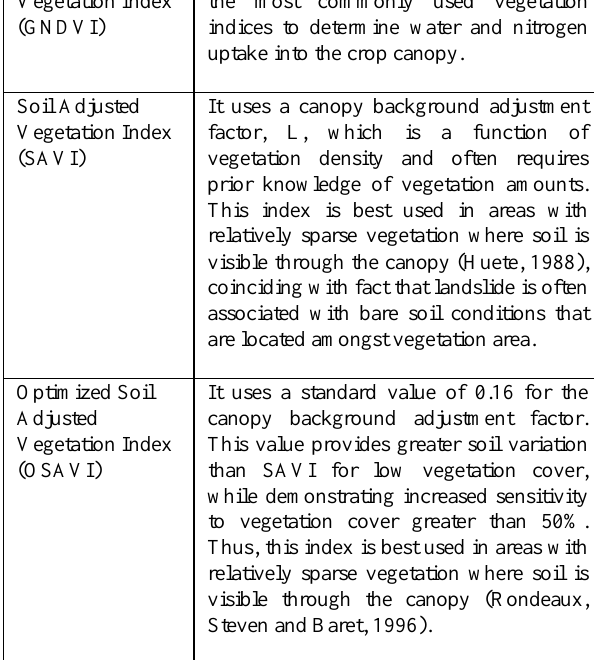
Table 3. Description of vegetation indices derived from satelite imageries trees measured at the TM Resorts, Kundasang. The diagram shows that most of the trees are oriented towards 10º to 30º from the North. The direction of the movement has been analyzed with the nearby active fault. The direction of inclined trees was parallel with the direction of the strike-slip fault.